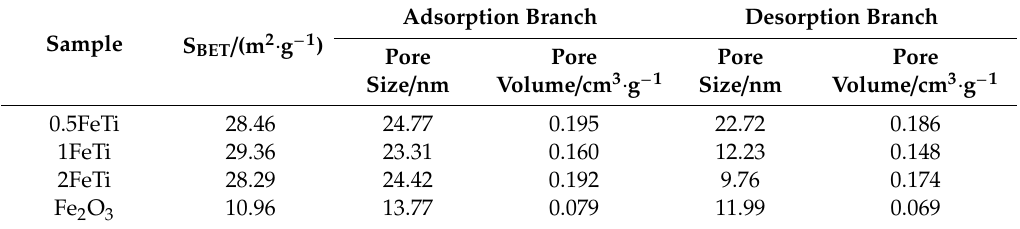
Figure 4. Nitrogen adsorption – desorption isotherms and the corresponding pore size distribution curves for 0.5FeTi ( A ), 1FeTi ( B ), 2FeTi ( C ), and Fe 2 O 3 ( D ). Table 2. BET surface area and BJH pore results of the as-prepared